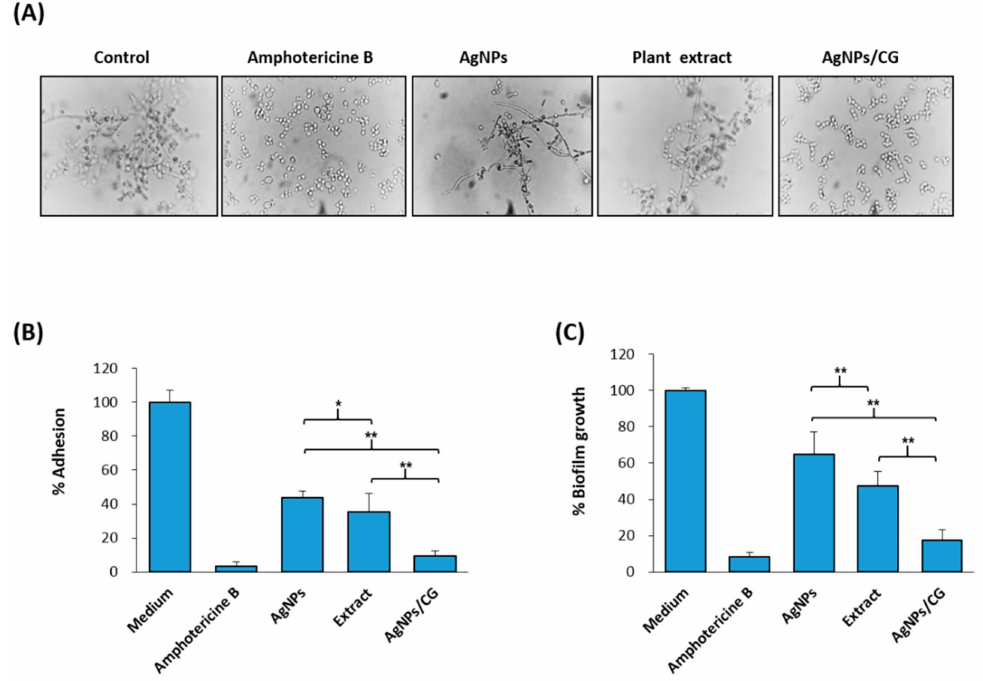
Figure 5. E ff ect of AgNPs on virulence factors of C. albicans. ( A ) Microscopic examination of the dimorphic transition in RPMI-1640 medium supplemented with either amphotericine b, AgNPs, or AgNPs / CG. Complete inhibition of the dimorphic transition (all cells were observed in yeast form when AgNPs and plant extract were combined, unlike when the two were tested on their own). ( B ) Percentage of adhesion after (2 h) in RPMI-1640 medium supplemented with 0.25% glucose. ( C ) Biofilm formation (after 24 h) as measured using an MTT metabolic assay. Values are the mean ± SD of three independent experiments (* p < 0.05, ** p <